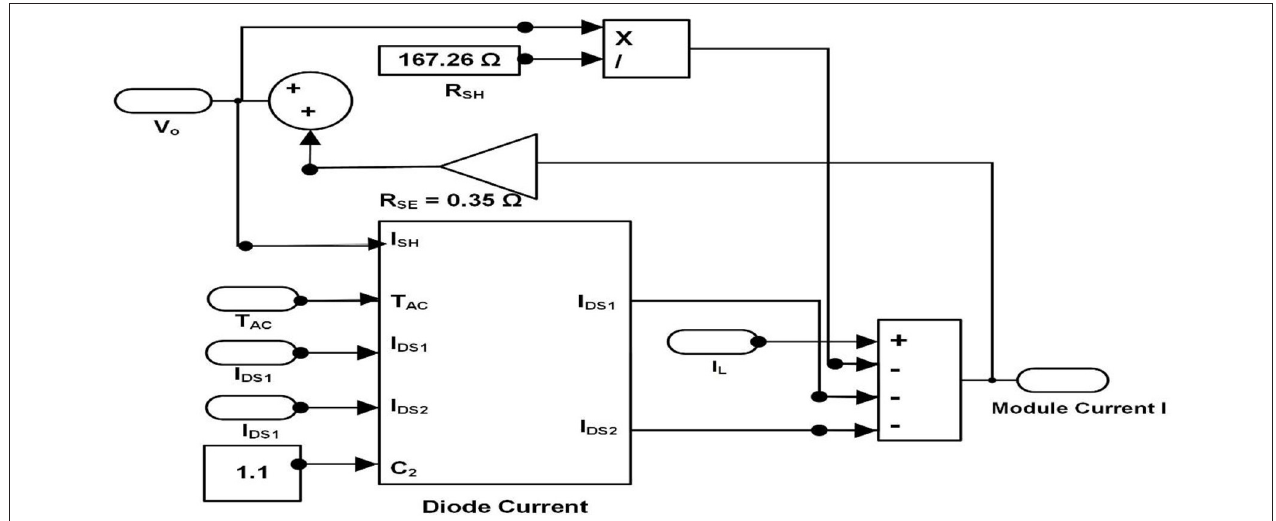
FIGURE 7 | Module output current (I) of proposed two-diode model.